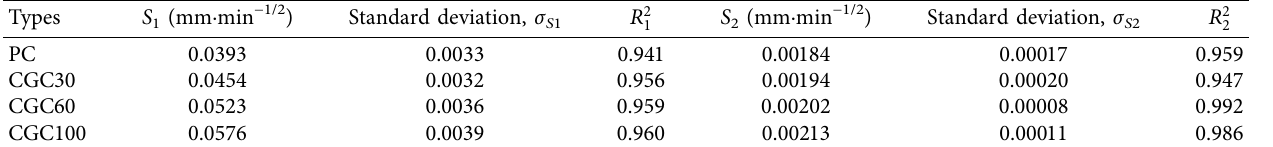
Table 3: Fitting results of the